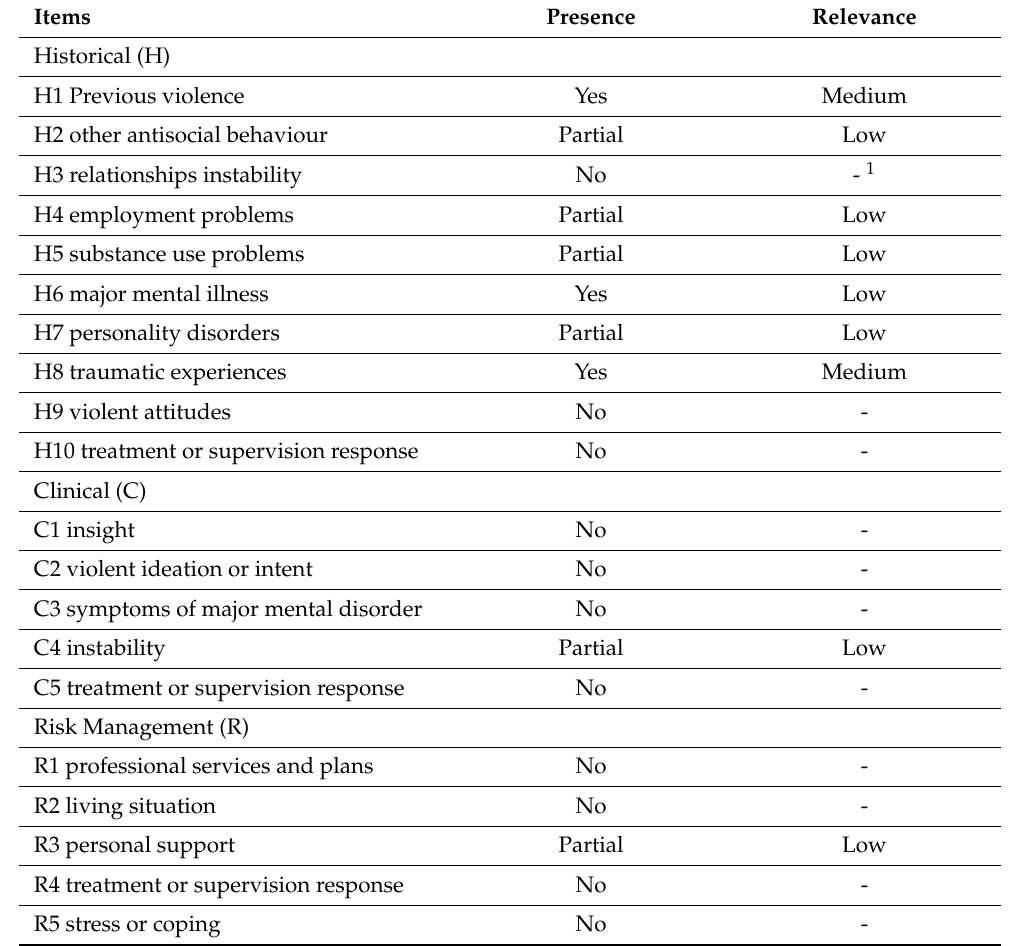
Table 11. Scores attributed to the items of the Historical Clinical Risk 20–Version 3 (HCR-20